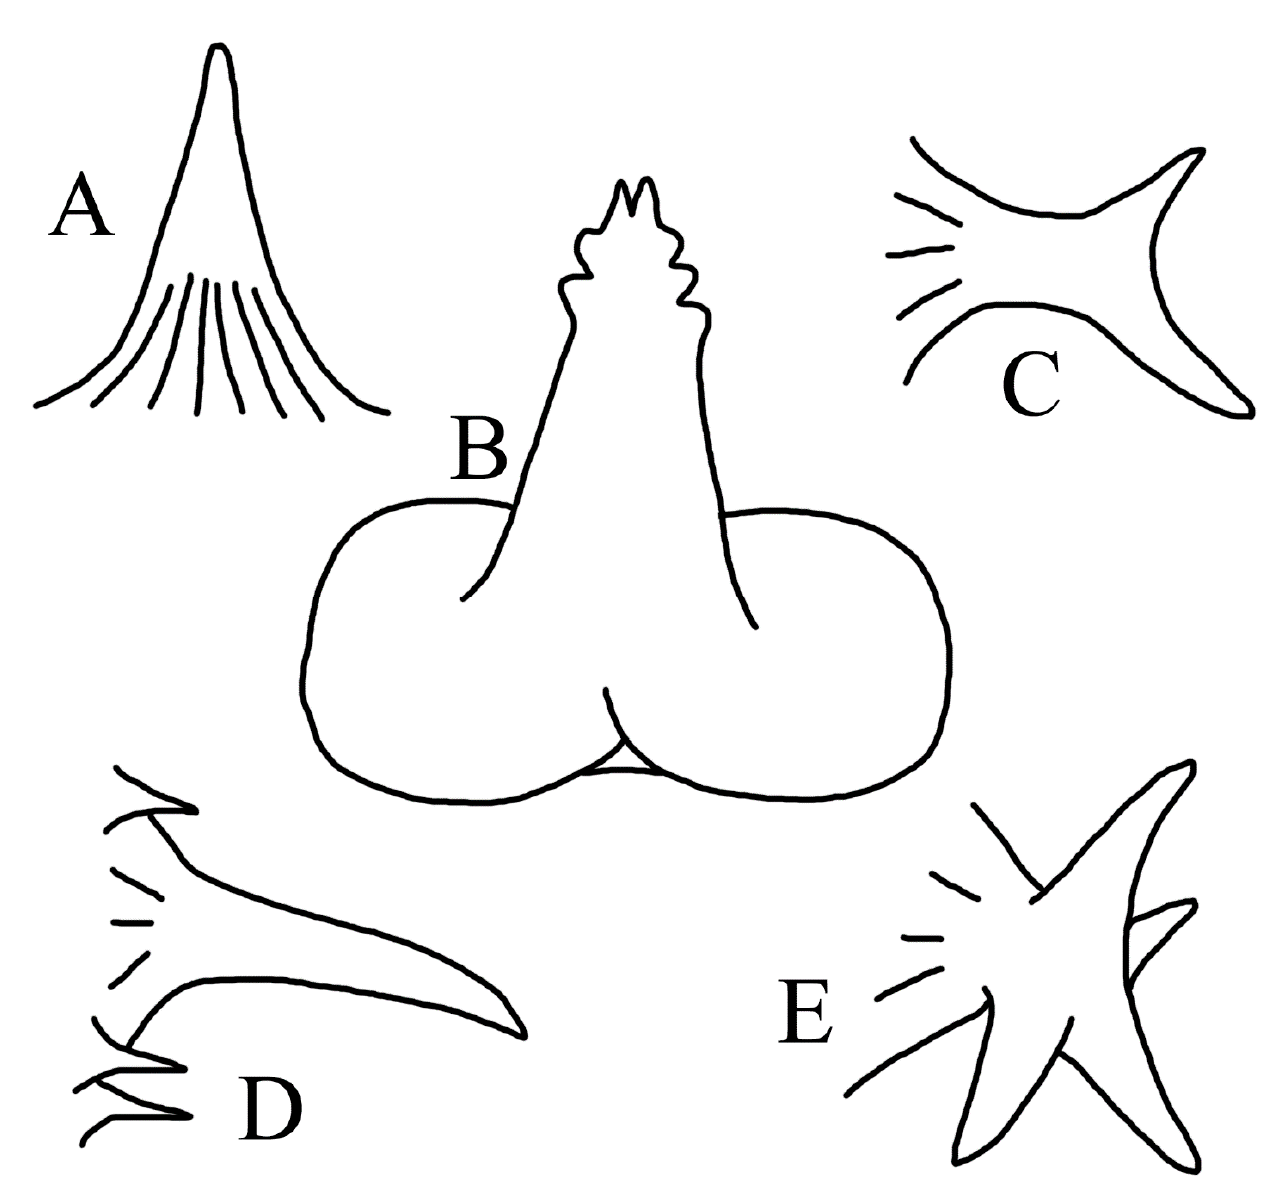
Figure 10. Esca and squamation of H. galatea Bradbury, 1988, from ZMMU P15825, 70.4 mm SL, Indian Ocean. ( A ). Rostral tubercle. ( B ). Esca. ( C ). Tubercle on disk margin. ( D ). Tubercle on tail. ( E) . Subopercular tubercle.